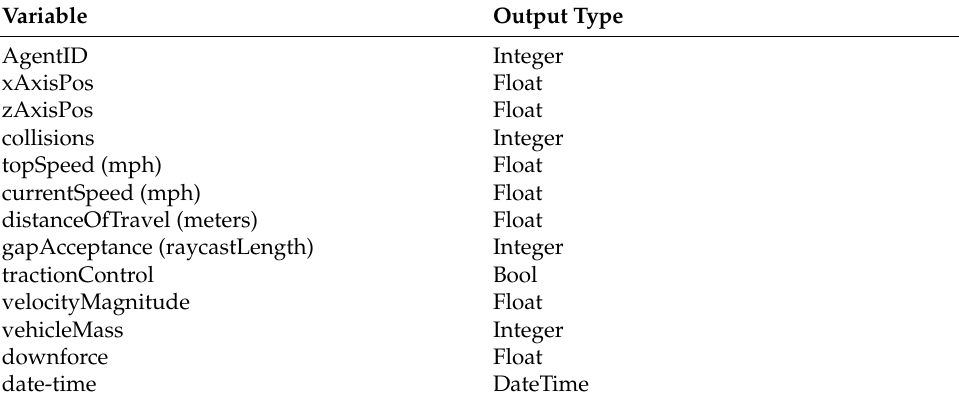
Table 2. Model output